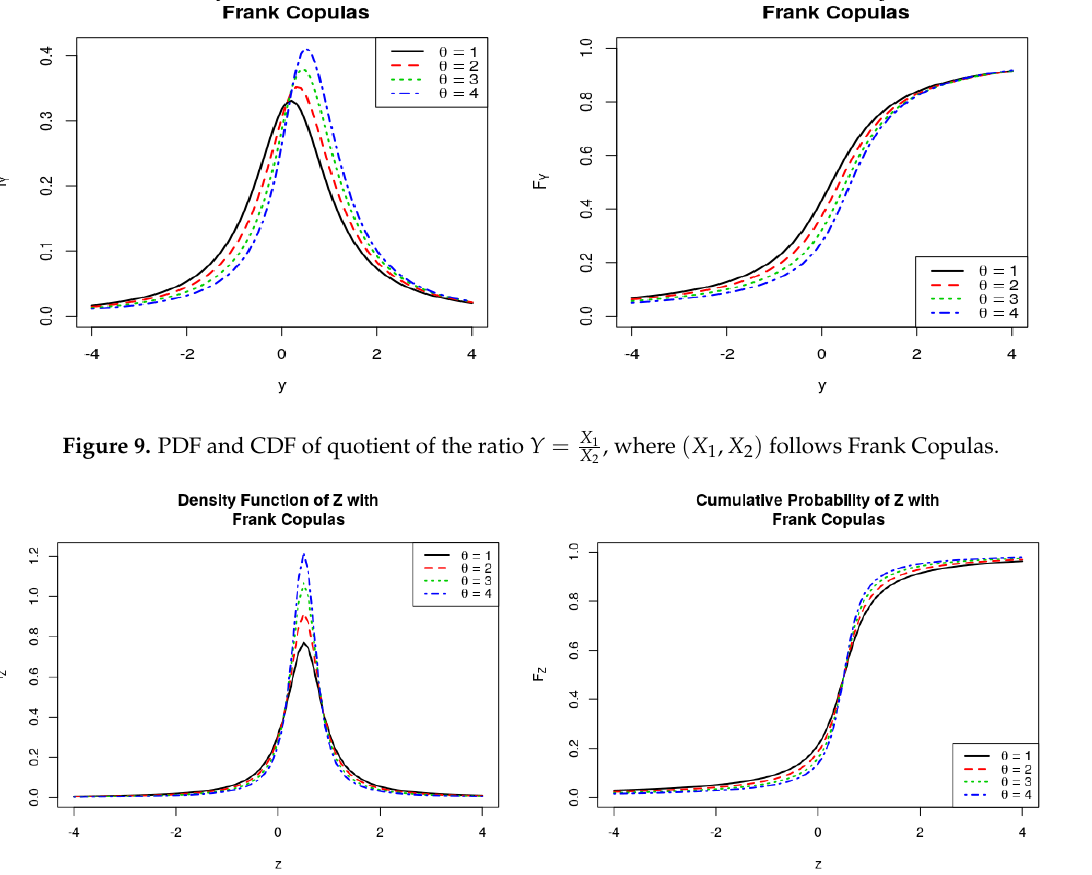
Figure 10. PDF and CDF of the ratio Z = X 1